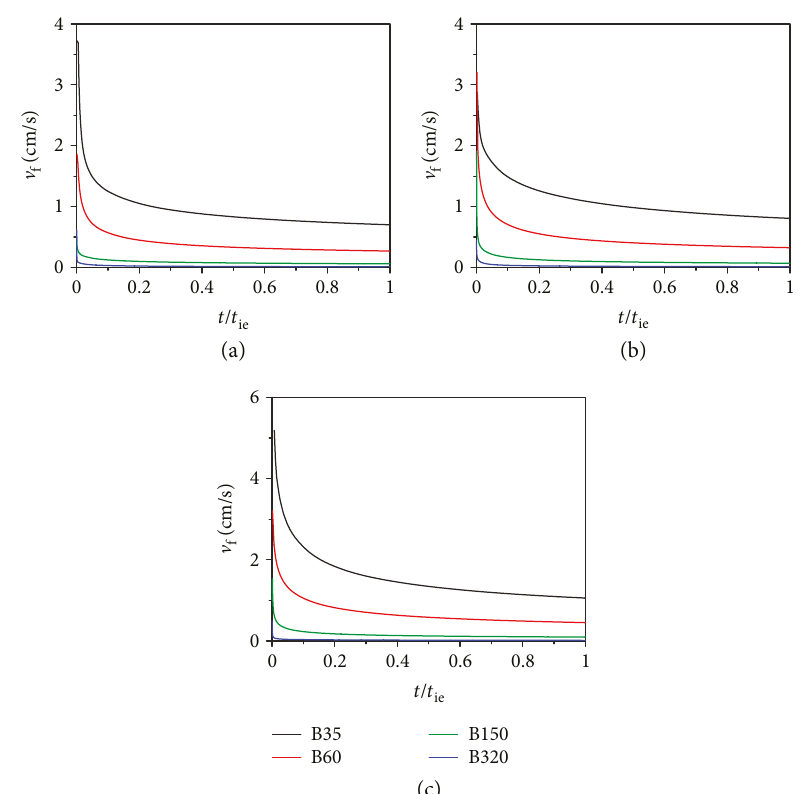
Figure 5: Wetting front velocity of sands B35, B60, B150, and B320 under ponding height of: (a) h = 40 h w